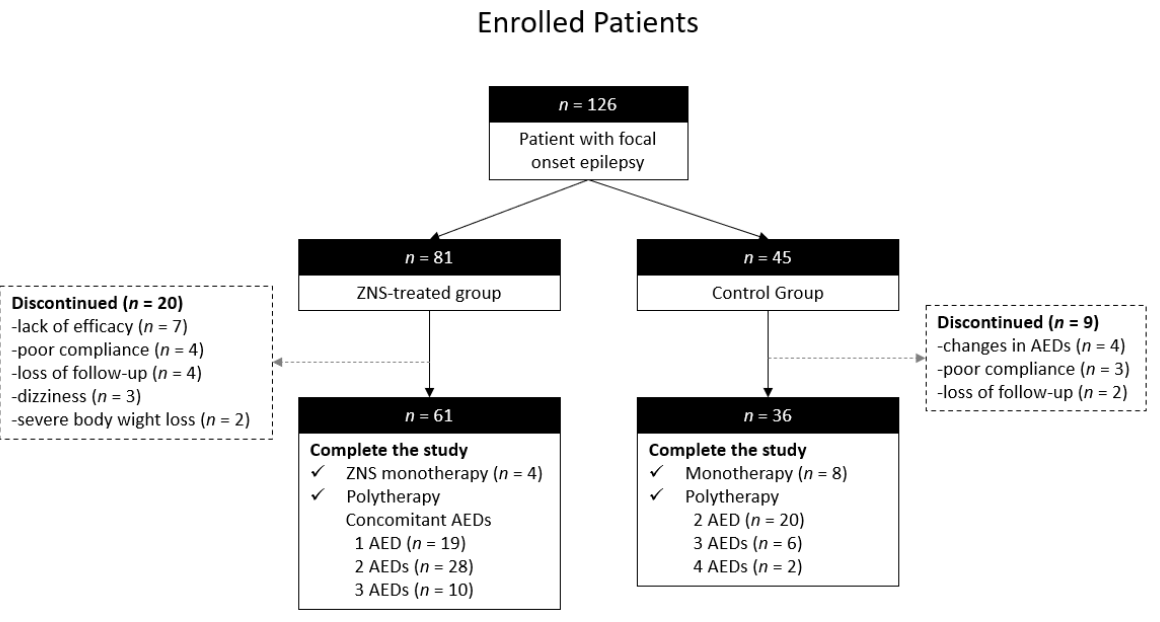
Figure 1. The algorithm of the enrolled patient in the present study. ZNS, zonisamide; AED, antiepileptic drug.